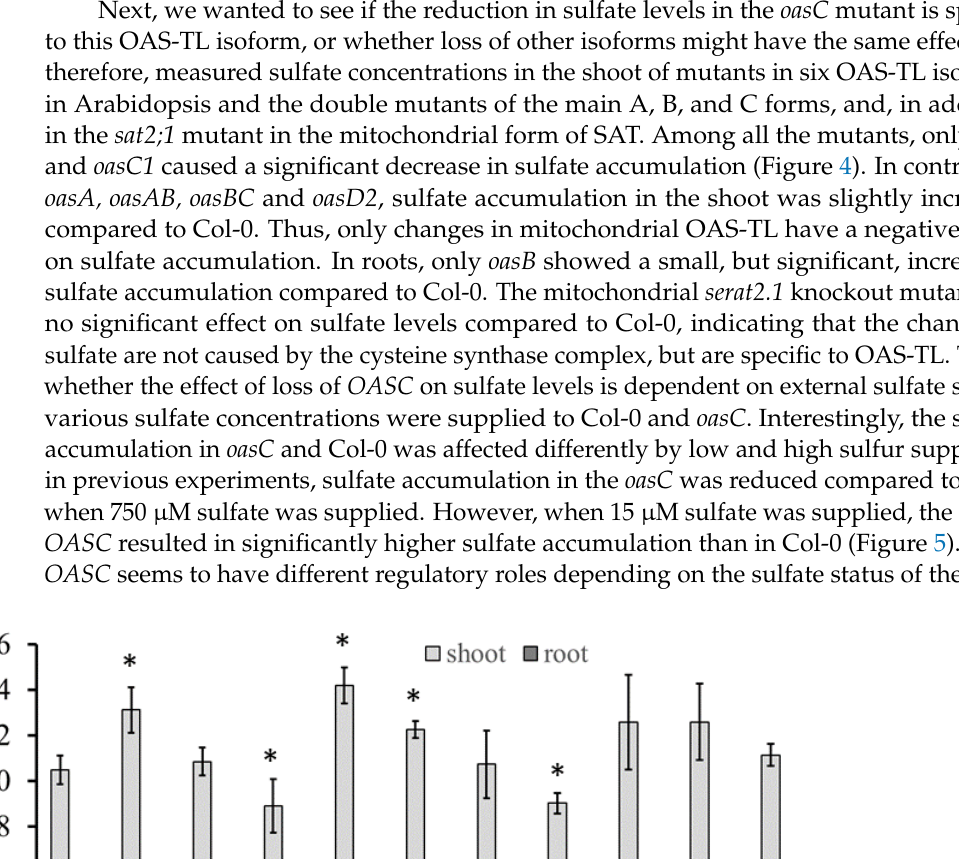
Figure 5. Exogenous sulfate supply affects sulfate levels in oasC mutant. Col-0 and oasC were grown on MS-agarose plates containing 15 µM, 45 µM, and 750 µM sulfate. Sulfate levels of the leaves were measured. Data are presented as means ± S.D. from four biological replicates. Asterisks mark values significantly different from the wild-type Col-0 at p < 0.05 (Student’s t -test). 2.2. Amino Acid Variation in OASC Responsible for Variation in Sulfate Level The OASC gene A_JCVI_8073 was identified in an associative transcriptomics with B. napus as linked to variation in sulfate content [17]. To find out the responsible genetic variation, the SNP markers within the OASC gene in 84 B. napus varieties used for the AT analysis were examined and connected to the sulfate content measured in Koprivova et al. [17] (Supplementary Table S1). Six haplotypes were found to be associated with a dif- ference in sulfate content. However, only one of them, JCVI_8073:377, was a non-synony- mous SNP, changing a Q 335 (the position corresponding to AtOASC) to R, and, therefore, likely to be the causative SNP (Supplementary Table S2). While other SNPs were linked to the JCVI_8073:377, they represented either synonymous SNPs or were located in the 3’non -translated region on the transcript. Thus, it seems that a Q 335 R amino acid change in